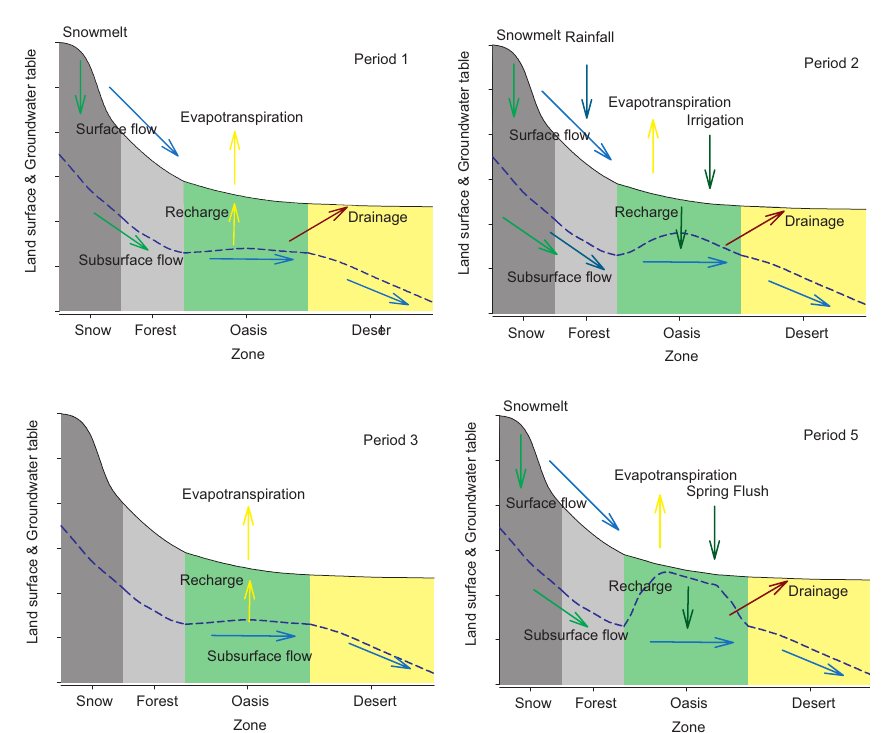
Figure 8. Sketch of seasonal groundwater dynamics (typical qualitative patterns in this